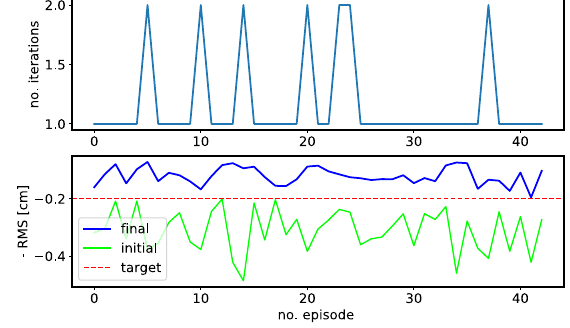
FIG. 11. Validation on accelerator of agent that was trained on simulation. The agent corrects the trajectory to better than 2 mm RMS within 1-2